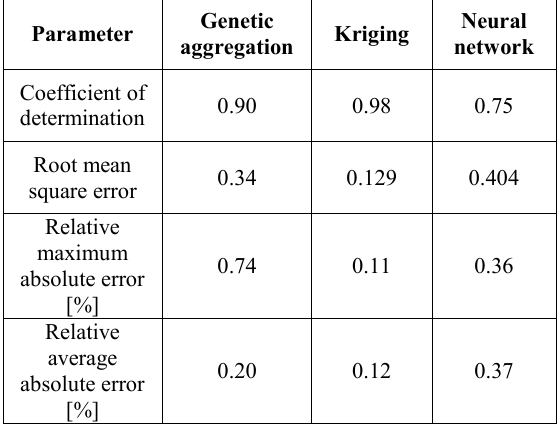
Table 1. Selected parameters of the response surface generated for the central composite design of experiment.